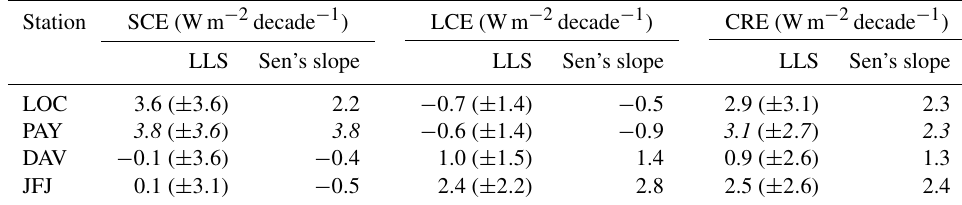
Table 5. Trend analysis of the shortwave and longwave cloud effects (SCE and LCE) and cloud radiative effect (CRE) for the 1996–2015 period at all four stations. Trends in italic (bold) are significant at the 90% (95%) confidence level. The 90% confidence interval of each trend is shown in brackets.